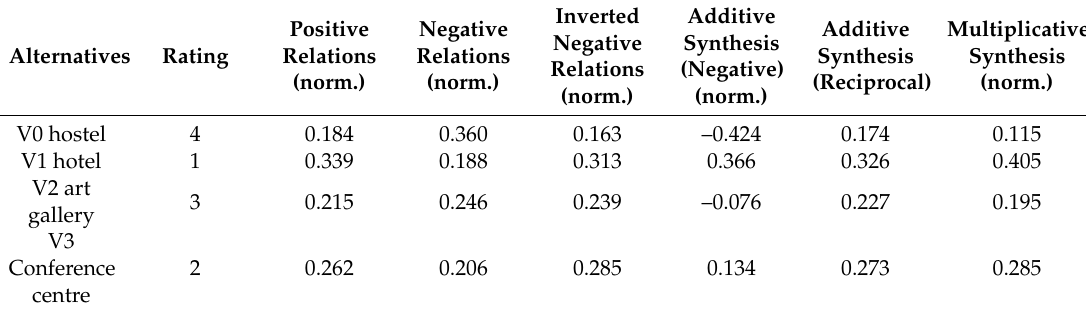
Table 4. Synthesis of results related to final assessments of the analysed alternatives.